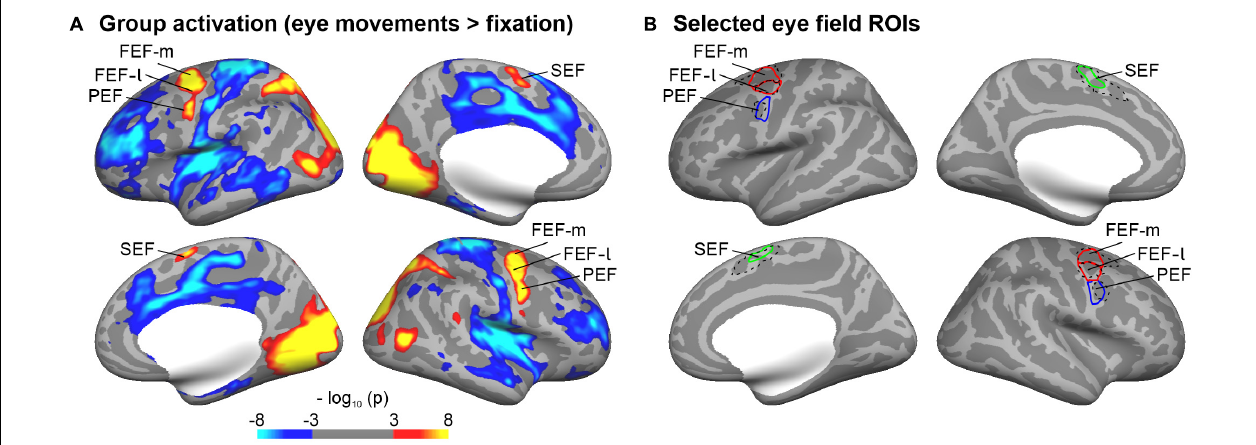
FIGURE 3 | Regions-of-interest (ROIs) of cortical representations of the eye fields. (A) Eye fields were identified in an independent sample that performed an eye movement task during functional MRI. The group maps show brain regions with significant (thresholded at p ≤ 0.001; FDR corrected) signal differences for the comparison eye movement versus fixation blocks (red/yellow: eye movements > fixation; blue: eye movements < fixation) overlaid on the inflated cortical surface of the Freesurfer average brain. (B) Selected ROIs of the eye fields (FEF-m, FEF-l, PEF, SEF). Eye fields were identified on the group maps thresholded at p ≤ 0.001 (see A ). In order to delineate the boundaries between FEF and PEF, an enhanced threshold ( p ≤ 0.0001) was adopted. The FEF was further sub-divided into a medial and lateral part as it overlapped with two separate parcellations (6a, FEF) of a multimodal imaging atlas (Glasser et al., 2016). The relevant atlas parcellations are shown in black dashed lines for